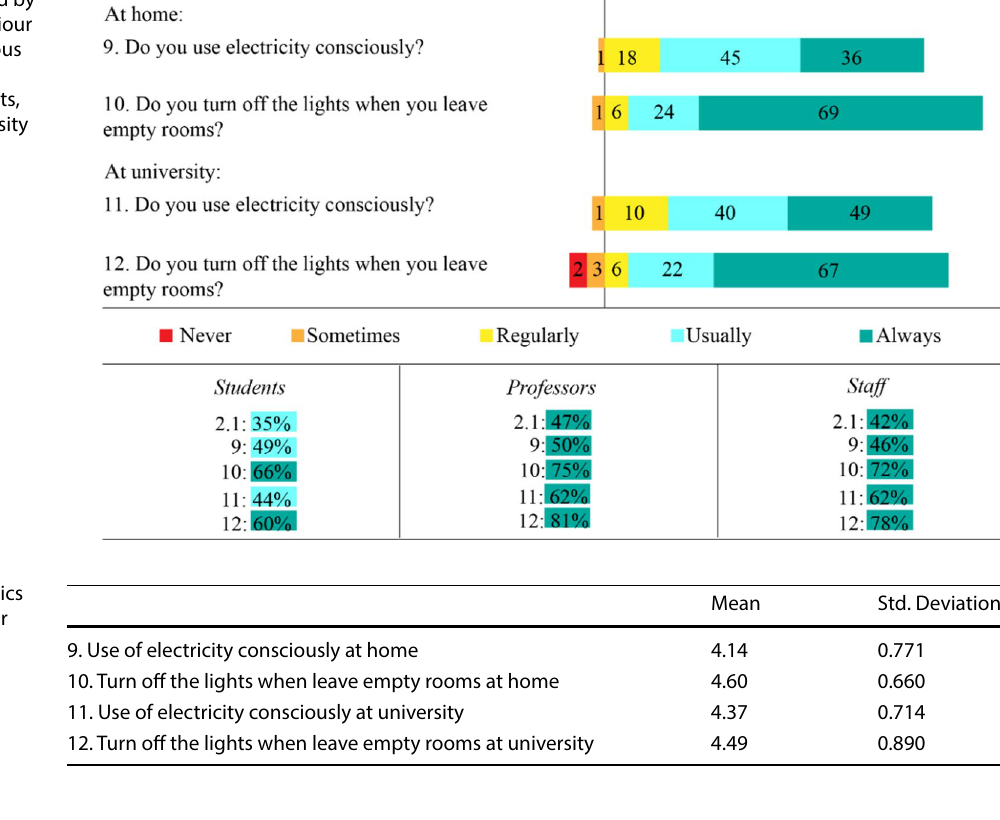
Table 3 Answers to the question 14: In your opinion, how can you contribute to the topic energy efficiency on campus together with